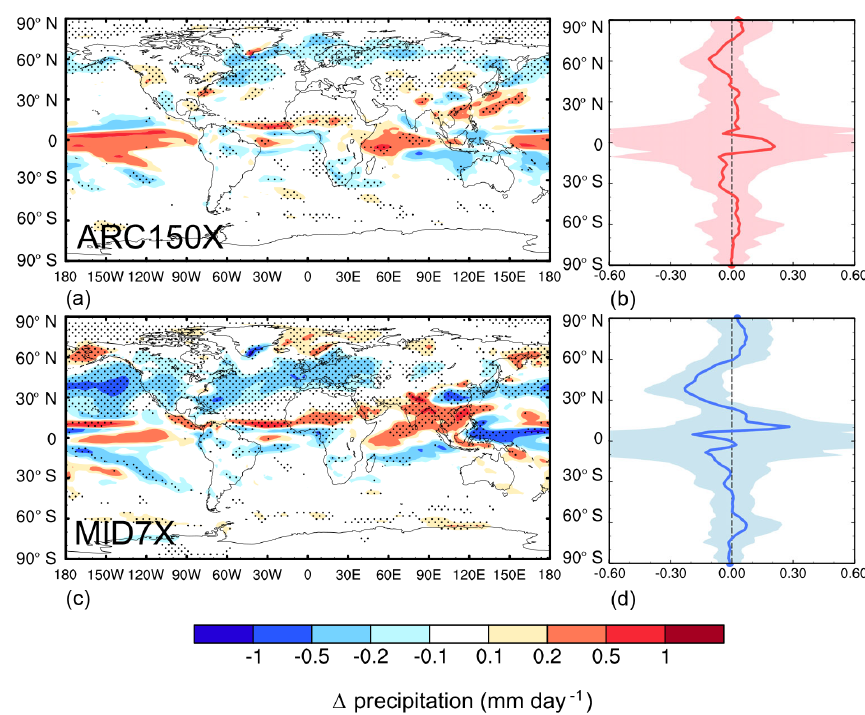
Figure 7. Spatial distribution (a, c) and zonal mean (b, d) of changes in annual mean total precipitation rate (mmday − 1 ) for ARC150X (a, b) and MID7X (c, d) compared to PD. The dotted areas in left panels indicate statistical significance with 95% confidence from a two-tailed Student’s t